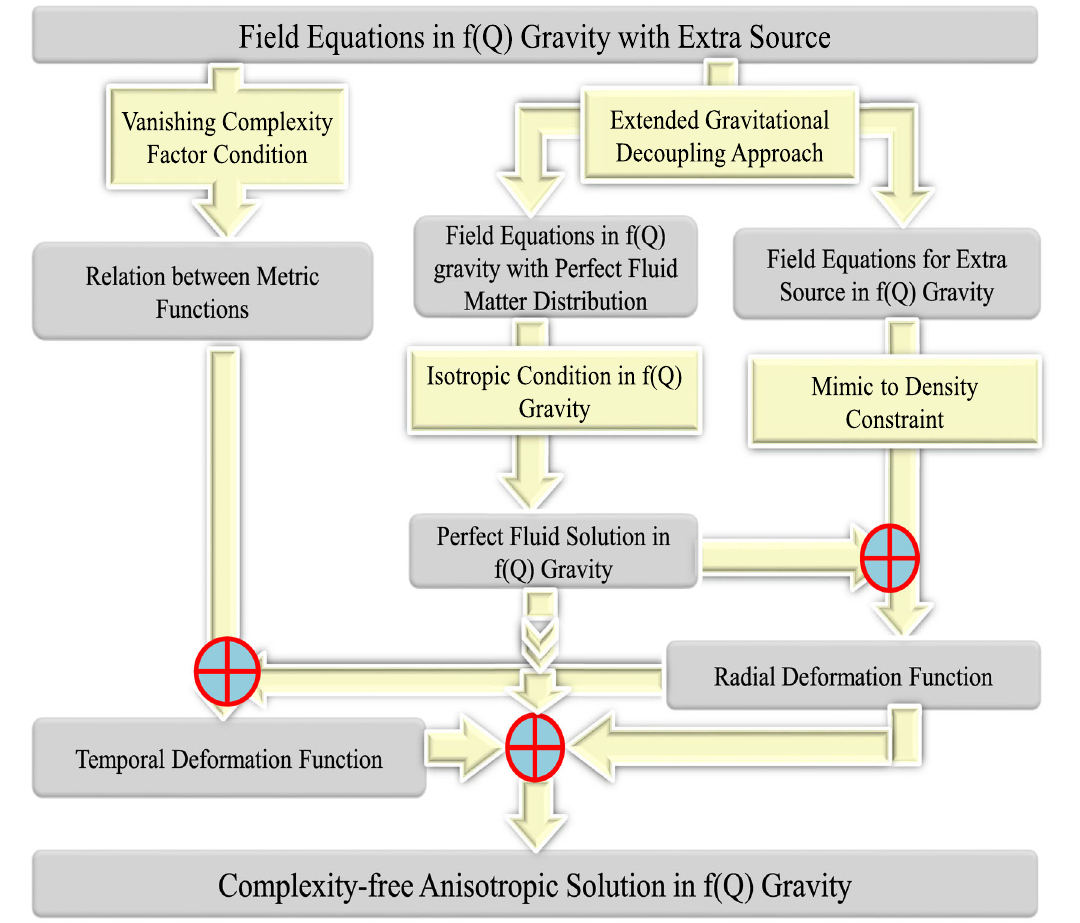
Fig. 1 TheflowchartforanisotropicgeneralizationofBuchdahl’sperfectfluidmodeltotheanisotropicdomainin f ( Q ) -gravityusinggravitational decoupling with the vanishing complexity factor